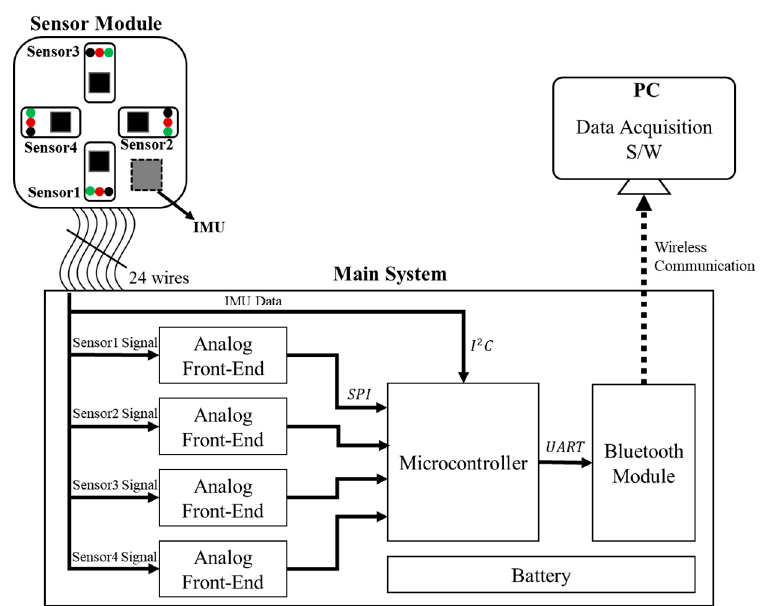
Figure 2. System diagram of the wearable multi-channel PPG acquisition system including PC application software (S/W). The solid line indicates a wired connection ( USART (Universal Asynchronous Receiver / Transmitter), SPI (Serial Peripheral Interface) and I2C (Inter-Integrated Circuit)) while the dashed line indicates a wireless connection.